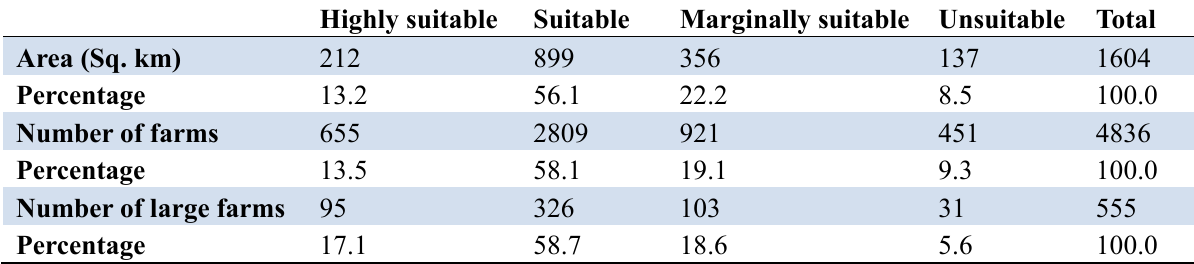
Table 2. Number of poultry farms in sites with different levels of suitability in Gazipur. Highly suitable Suitable Marginally suitable Unsuitable Total Area (Sq. km) 212 899 356 137 1604 Percentage 13.2 56.1 22.2 8.5 100.0 Number of farms 655 2809 921 451 4836 Percentage 13.5 58.1 19.1 9.3 100.0 Number of large farms 95 326 103 31 555 Percentage 17.1 58.7 18.6 5.6